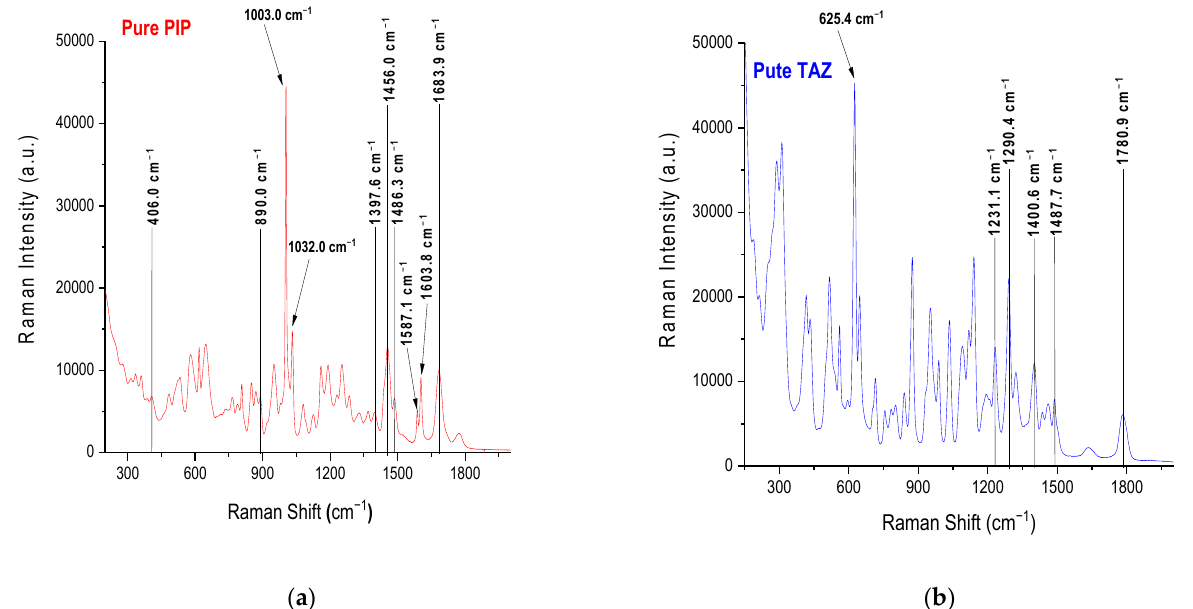
Figure 1. ( a ) Raman powder spectrum of pure piperacillin (PIP) and ( b ) Raman powder spectrum of pure tazobactam (TAZ). The peaks highlighted are the ones that are attributed to vibration modes in bibliography. The samples were placed on a g.slide. Table 1. Characteristic peaks of pure APIs and their attribution to vibration modes according to bibliography.